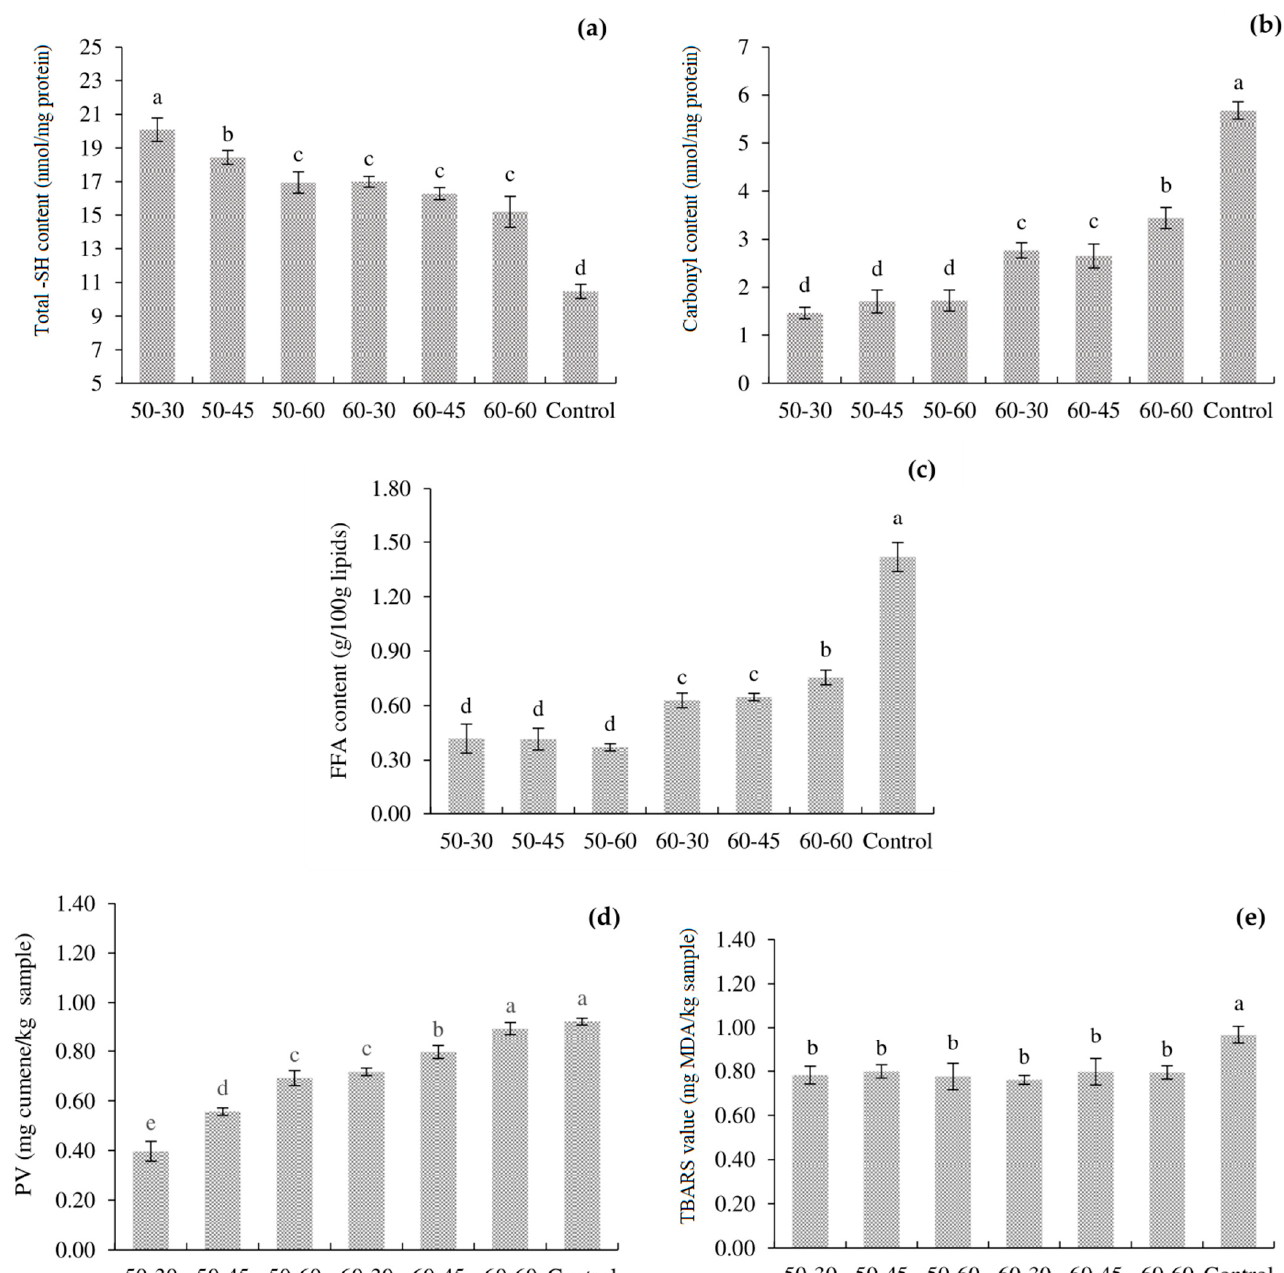
Figure 1. Total -SH content ( a ), carbonyl content ( b ), FFA content ( c ), PV ( d ) and TBARS value ( e ) of SV-cooked tilapia processed by various SV conditions. Different lowercase letters indicate significant differences ( p < 0.05).